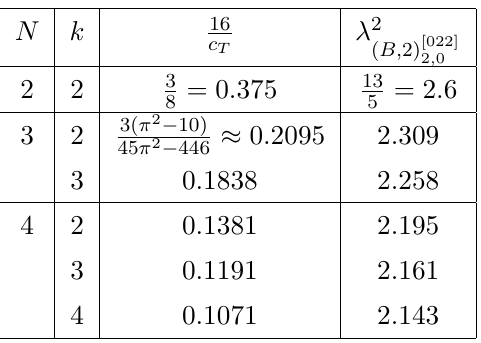
and λ 2 in various U( N ) k × U( N ) − k ABJM c T ( B, 2) [022] 2 , 0